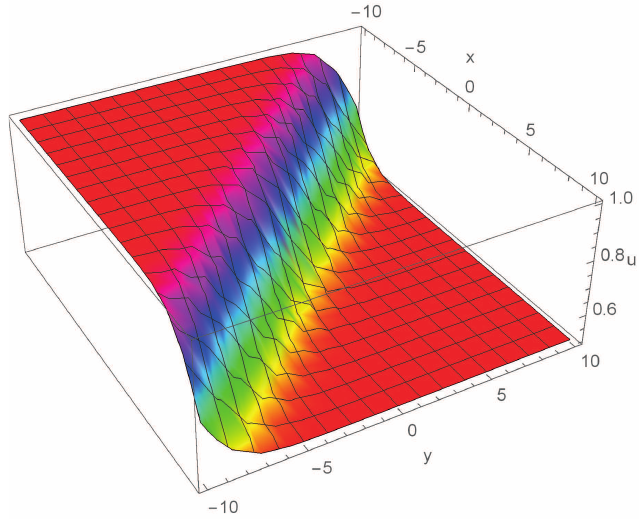
Fig. 2 The surface plot of the PIA solution v 4 ( x , y , t ) for ℜ = 100 and t = 0 . 1 when α = 0 . 75 .